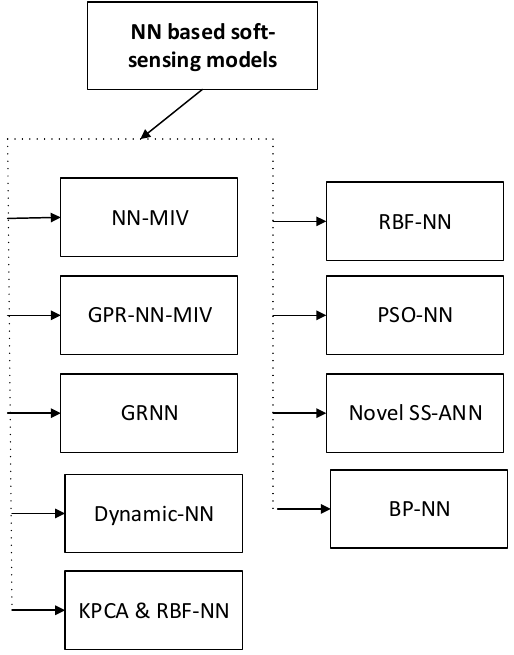
Figure 6. NN-based soft-sensing models (abbreviations are listed in Table A1).